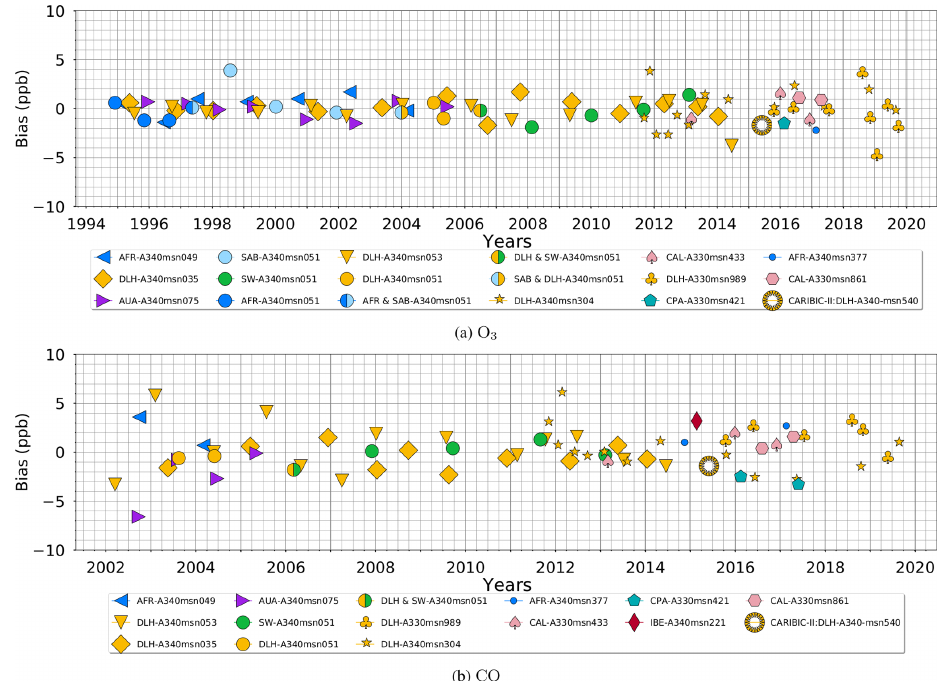
Figure 10. Internal consistency of the long-term O 3 (a) and CO (b) measurement time series within the IAGOS program. Different symbols are used to differentiate between the aircraft, and different colors are used for each airline. Symbol positions show the flight intercomparison measurement mean bias for an instrument FP centered in the middle of the period. For CARIBIC, the symbol is position arbitrarily on the timescale (see